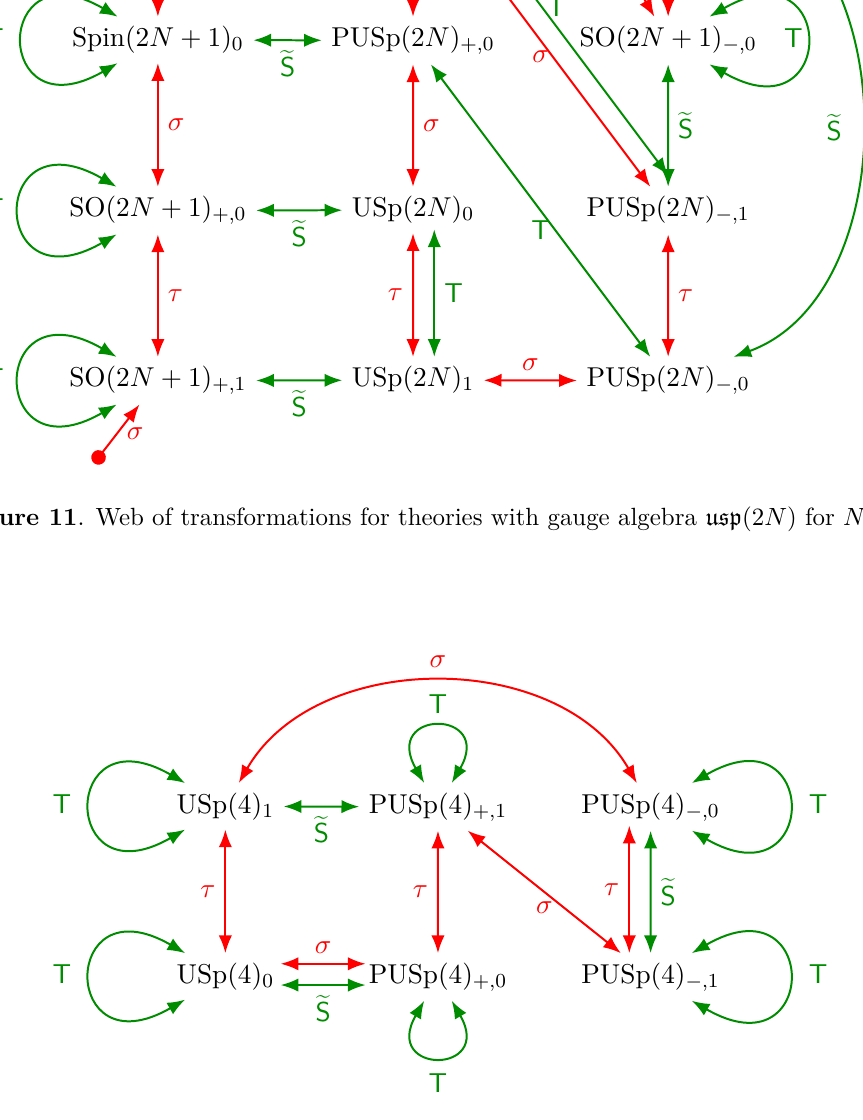
Figure 12 . Web of transformations for theories with gauge algebra usp (4)